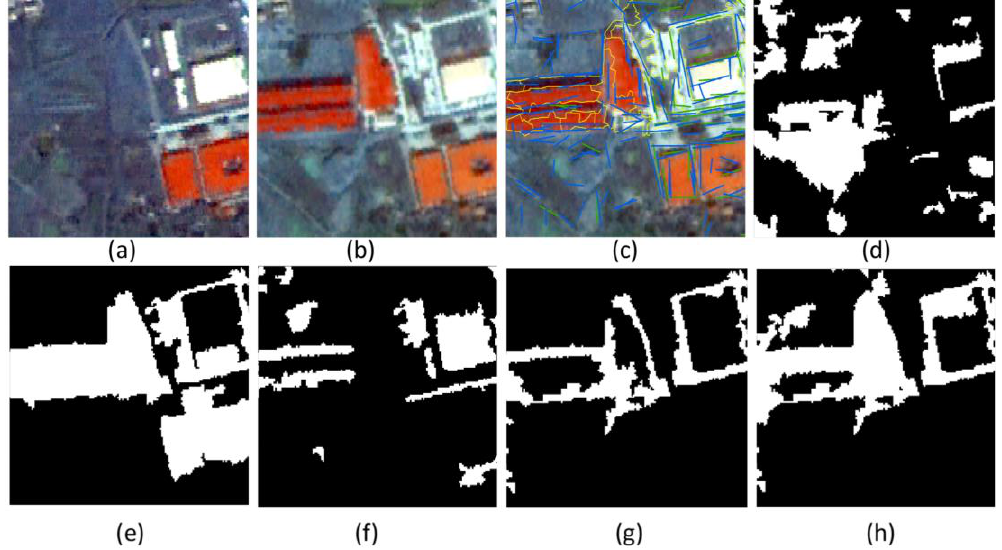
Figure 9. Enlarged area 2. ( a , b ) Original images. ( c ) TRPs and TLPs. ( d ) Result of CVA. ( e ) Result of PCA-k-means. ( f ) Result of IRMAD. ( g ) Result of initial detection. ( h ) Result after refinement.